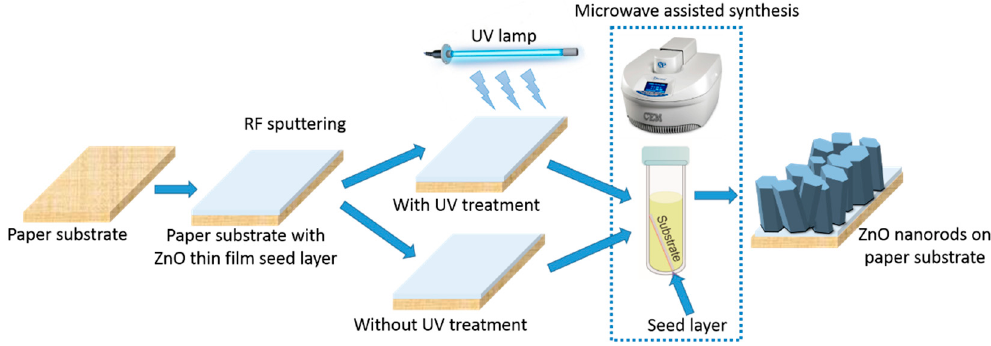
Figure 13. Schematic of ZnO nanorods hydrothermal synthesis assisted by microwave irradiation on paper substrate with a ZnO thin film seed layer deposited by sputtering method.